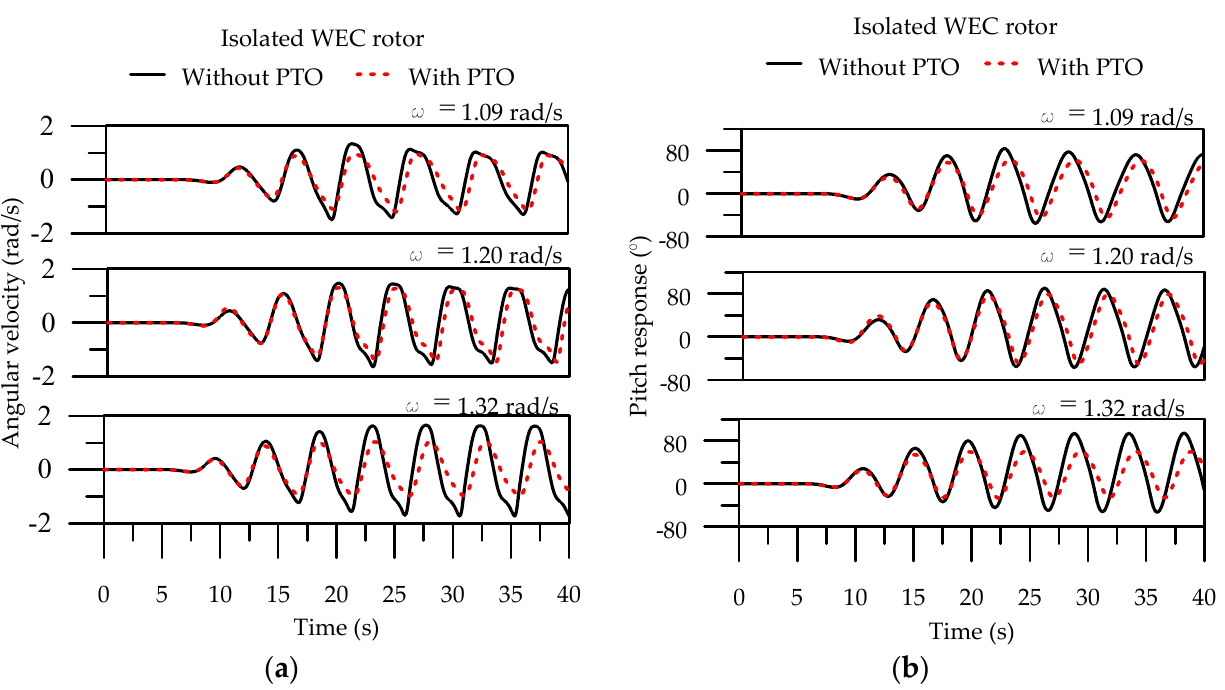
Figure 10. Numerical comparison of isolated WEC rotor with and without PTO for different wave frequencies: ( a ) angular velocity and ( b ) pitch response.